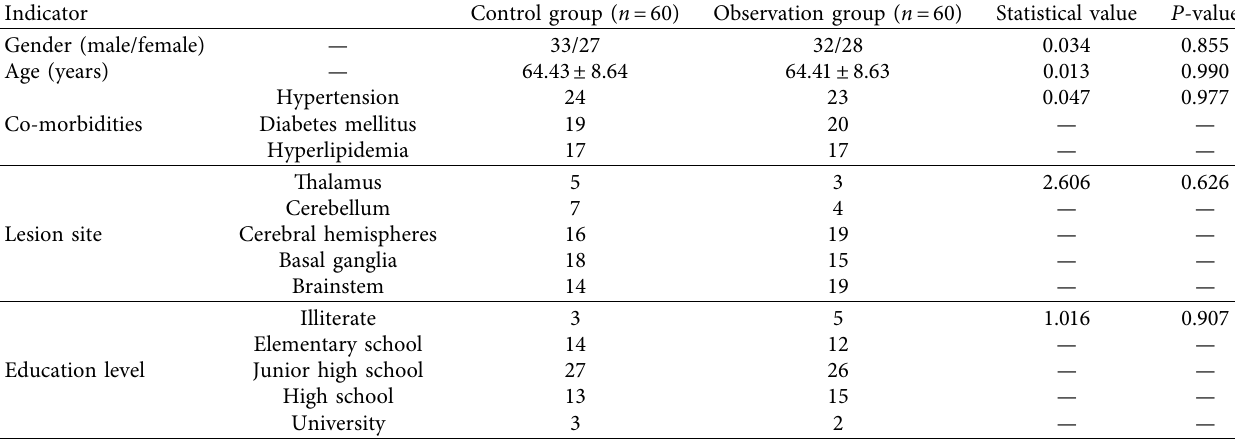
Table 1: Comparison of the general data of the two groups of patients.